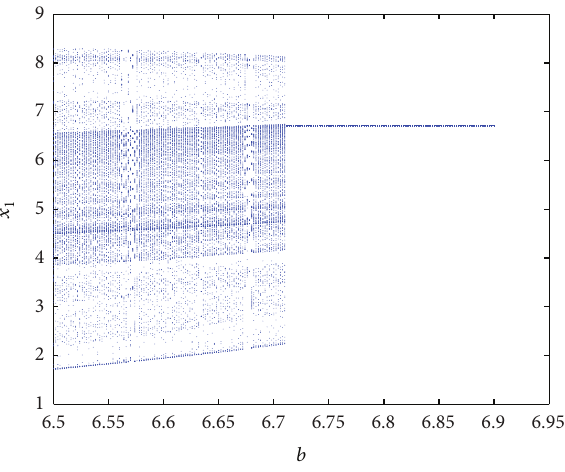
Figure 6: Bifurcation diagram of map (48).